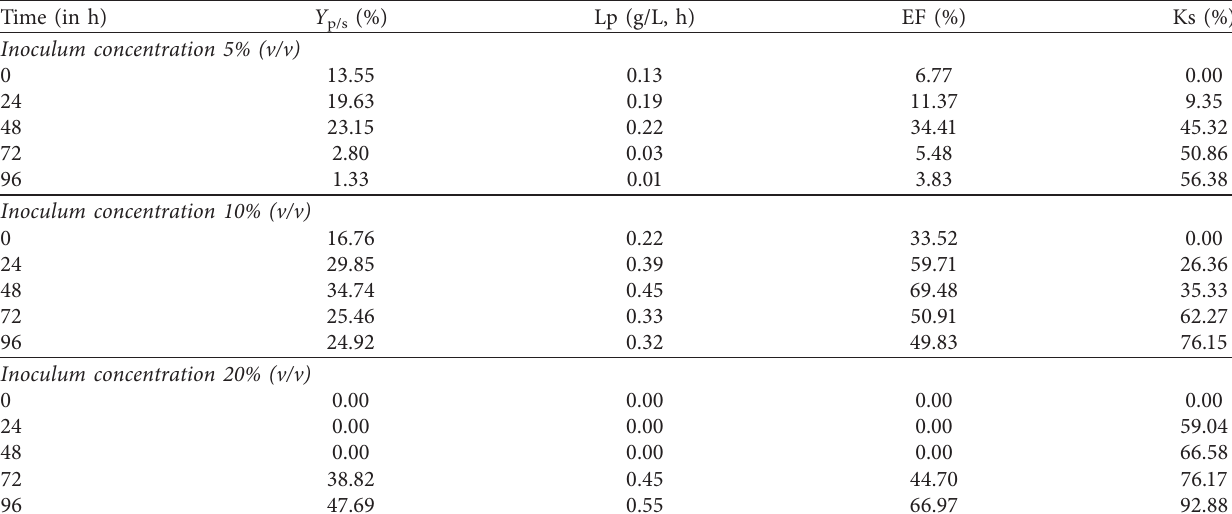
Table 5: Substrates and product parameters observed during